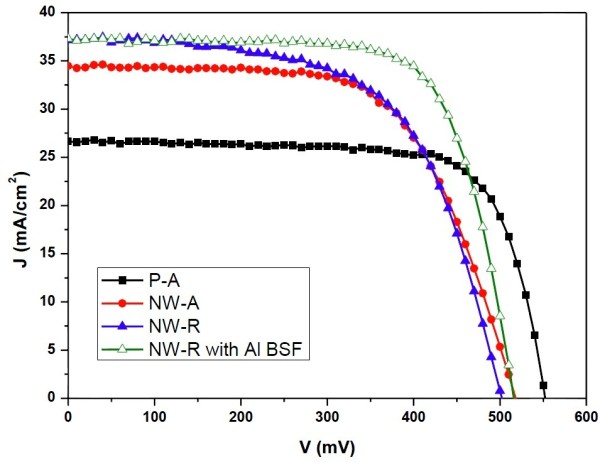
J-V curves of the solar cells under AM1.5 illumination. The J-V curve for NW-R solar cell with Al back field is also included.